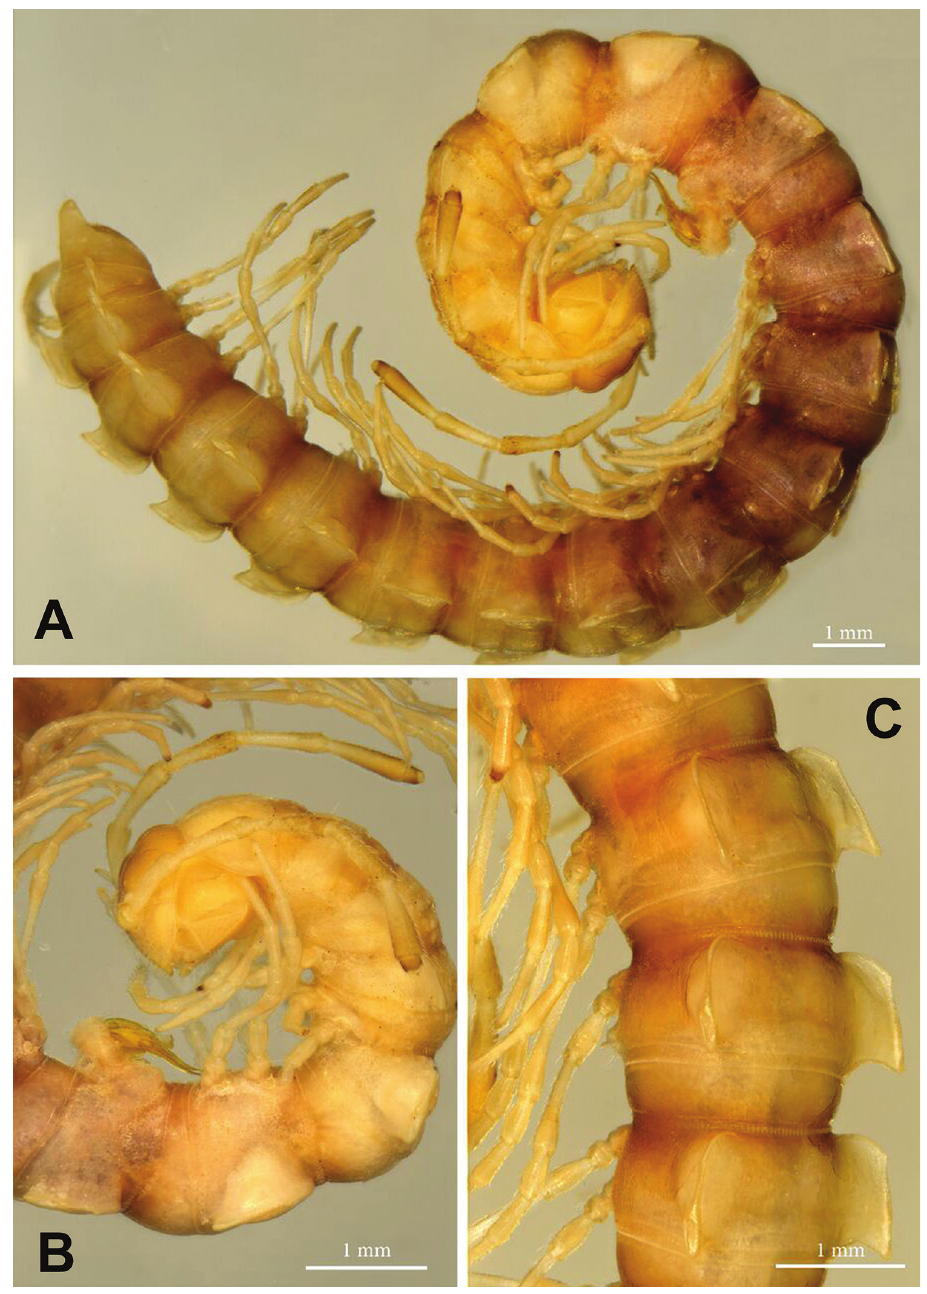
Figure 1. Annamina xanthoptera Attems, 1937, ♂ paralectotype (NHMW). A habitus, lateral view B anterior part of body, lateral view C midbody segments, dorsolateral